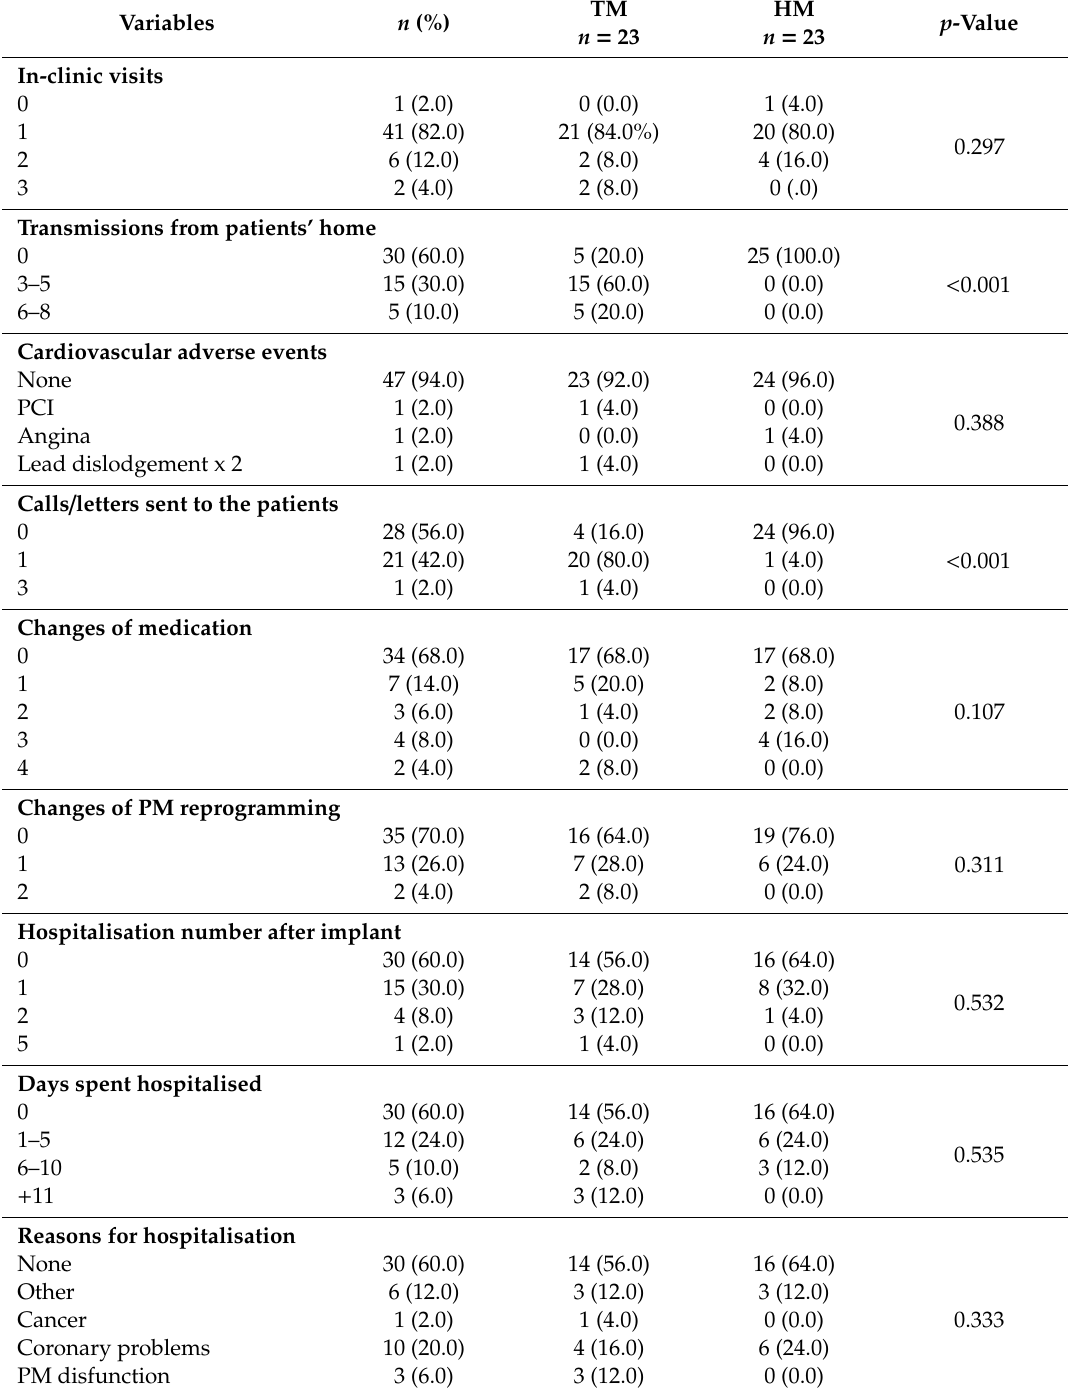
Table 4. Follow-up information at 12